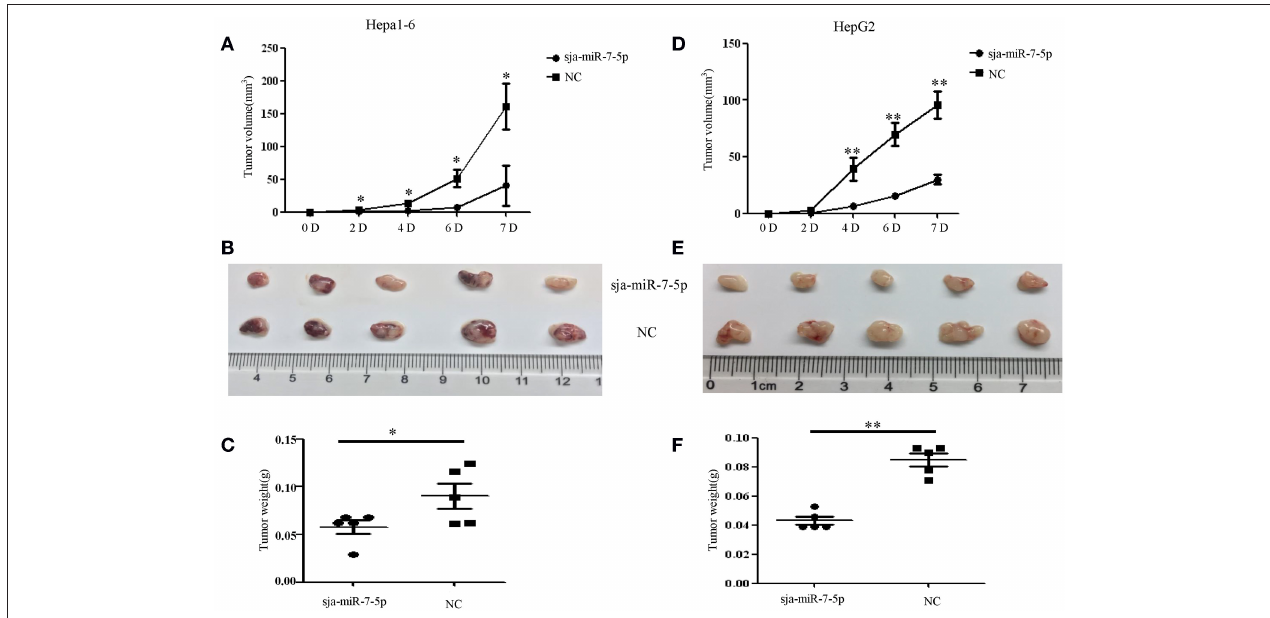
FIGURE 3 | Sja-miR-7-5p inhibits hepatoma cell growth in vivo . (A–F) Hepa1-6 and HepG2 cells were transfected with sja-miR-7-5p mimics or NC mimics, respectively, and then the sja-miR-7-5p-treated cells (1 × 10 6 ) were injected subcutaneously to the left scapula of athymic nude mice, and the NC-treated cells were injected subcutaneously into the right scapula ( n = 5), respectively. Tumor volumes were measured at days 2, 4, 6, and 7 after injection. At day 7, the mice were sacrificed and tumors were separated to measure their weight and volume, (A–C) for Hepa1-6 cells, (D–F) for HepG2 cells. Data are presented as the mean ± SD, n = 5, * p < 0.05, ** p <